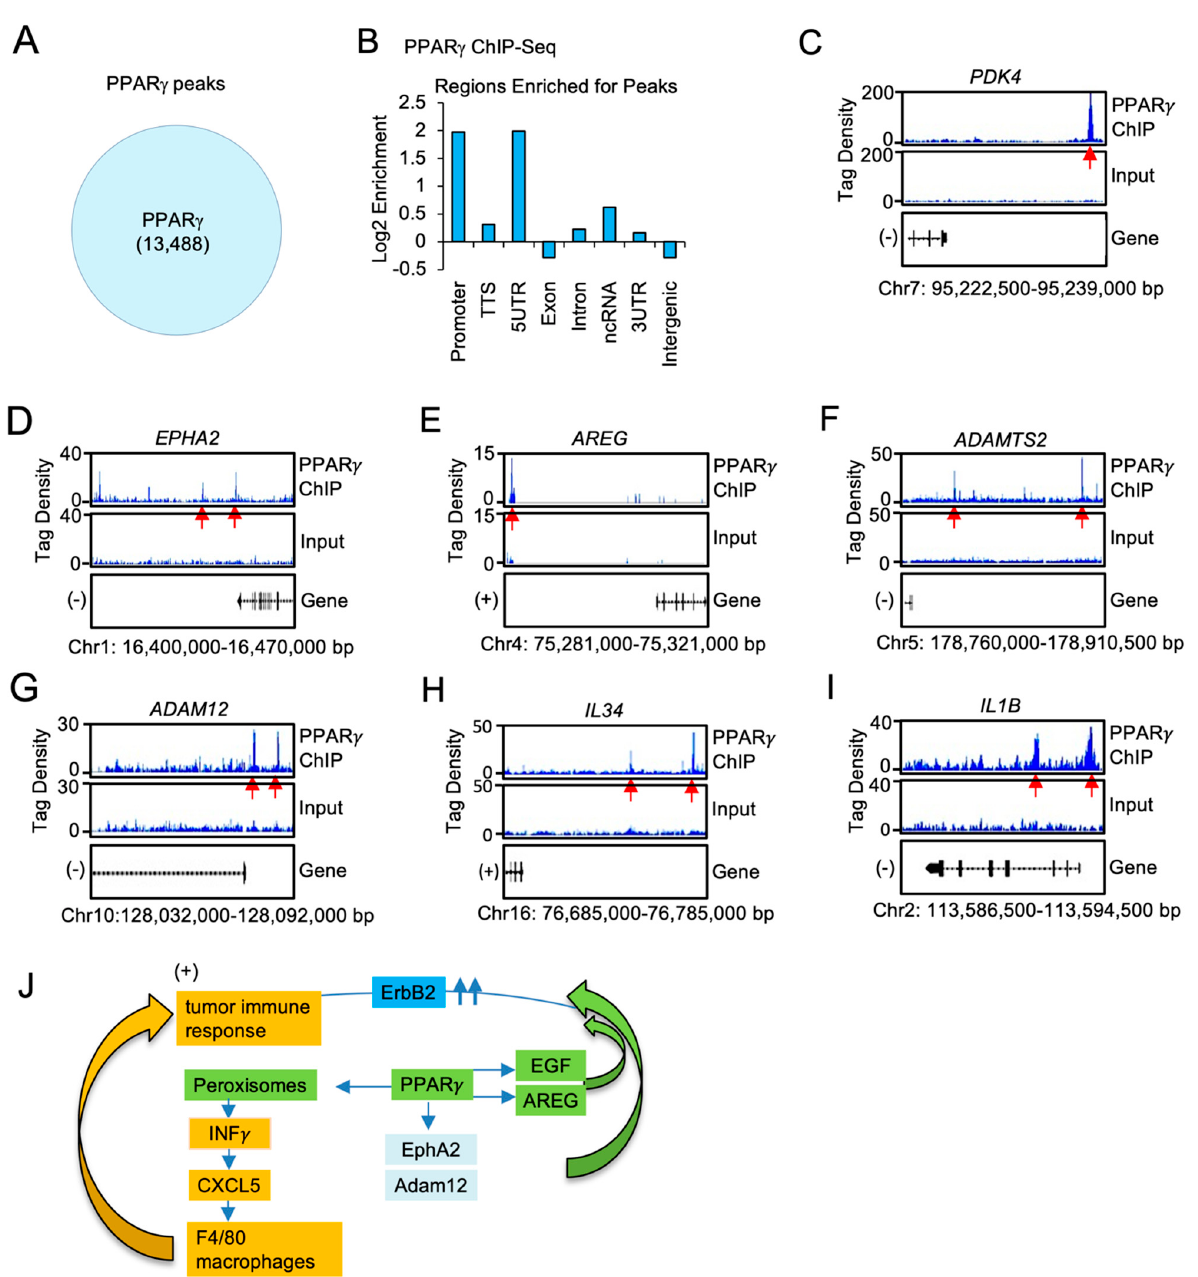
Figure 6. PPAR γ 1 binding in chromatin to growth factor and cytokine/chemokine signaling module genes, in ErbB2 mammary tumors. ( A ). ChIP-Seq analysis was performed on samples derived from MCF10A-NeuT transduced with PPAR γ Wt and peak calling defined by MACS2 software is shown in the Venn diagram. ( B ). Distribution of PPAR γ Wt peaks relative to the TSS. The region upstream from the TSS was divided as indicated. ( C ). Integrated genome browser visualization of tag density profiles for ChIP-Seq PPAR γ Wt of selected genes in the PPAR γ 1 target gene (PDK4), ( D–G ). the growth module EphA2, Amphiregulin, ADAM12, ADAMTS2 and ( H,I ), the interferon/cytokine module of IL1B, IL34. ( J ). Schematic representation of model in which PPAR γ 1 determines binding to cytokine/chemokine and growth factor